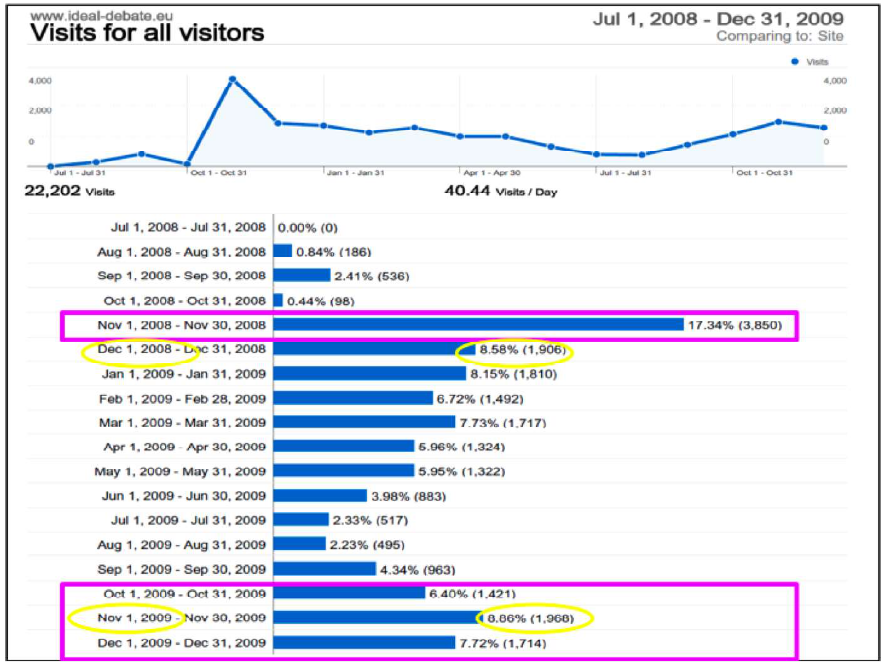
Figure 6: Traffic statistics on the IDEAL-EU SNP during the